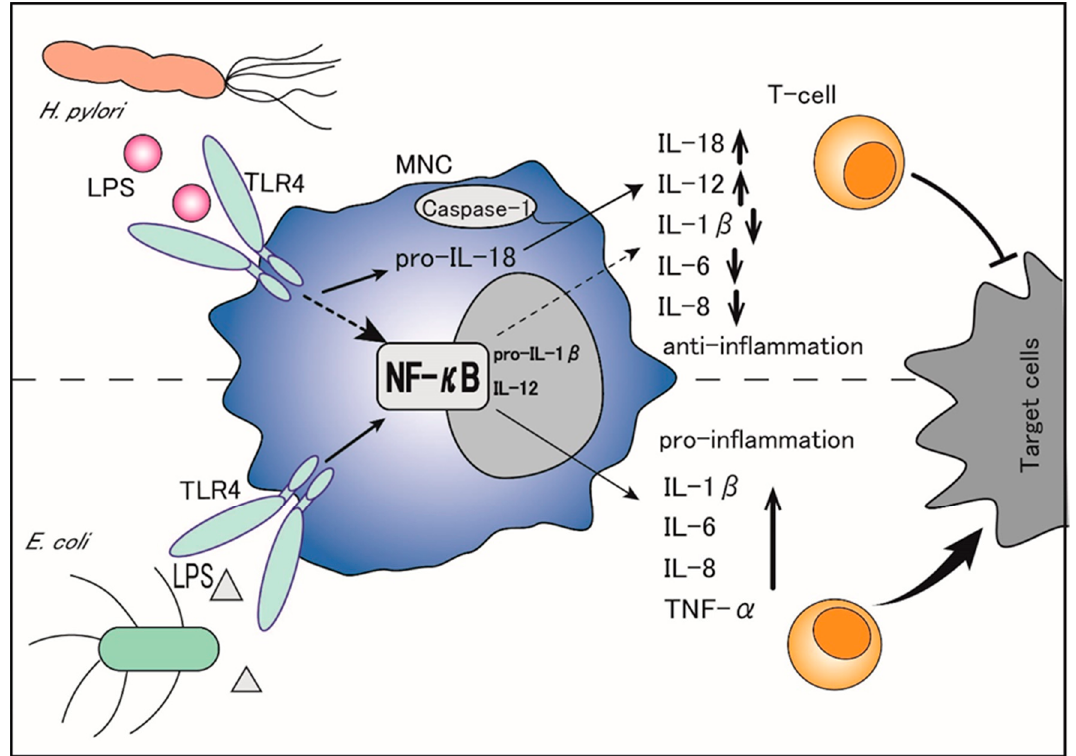
Figure 1. Di ff erence in inflammatory reactions between H. pylori lipopolysaccharide (LPS) and E. coli LPS. E. coli LPS stimulates mononuclear cell (MNC) to upregulate the production of interleukin (IL)-1 β , IL-6, IL-8, and tumor necrosis factor- α (TNF- α ), whereas H. pylori LPS has an anti-inflammatory e ff ect that selectively upregulates IL-18 and IL-12 but inhibits other cytokines, leading to the suppression of T cell surveillance, which promotes gastric cancer initiation and